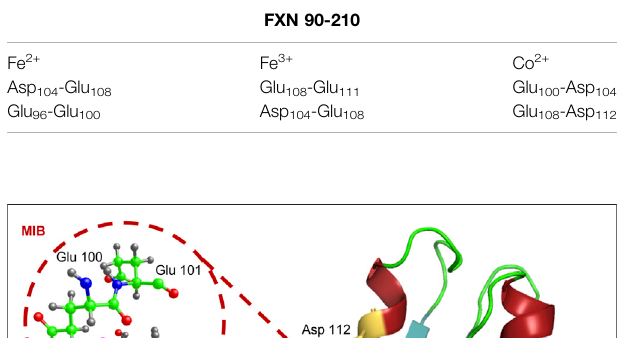
TABLE 3| Pairs ofresidues to which MIB assigns the highest score asFe 2+ , Fe 3+ , and Co 2+ metal-binding sites in wt-FXN 90-210.